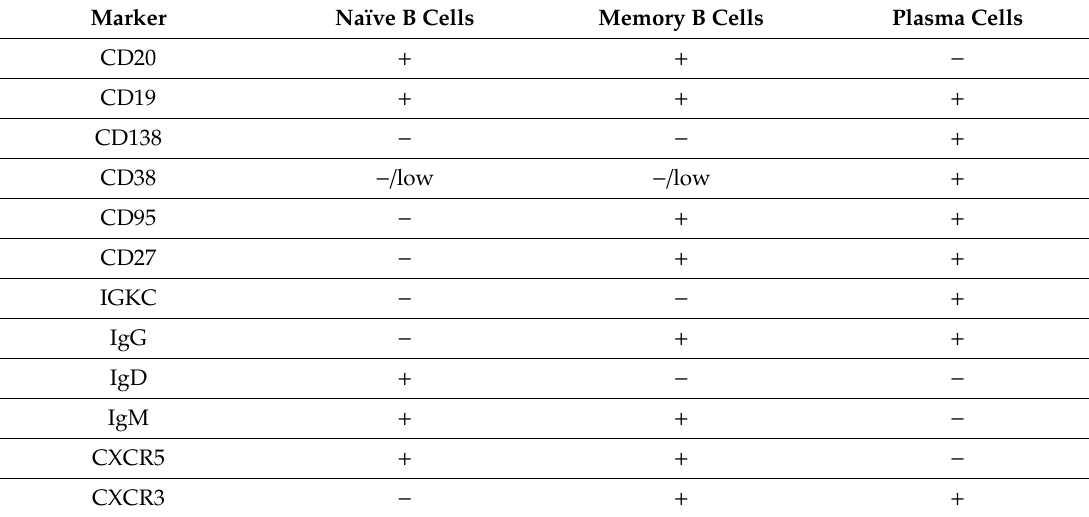
Table 1. List of B cell markers used to characterize B cell subtypes in ovarian